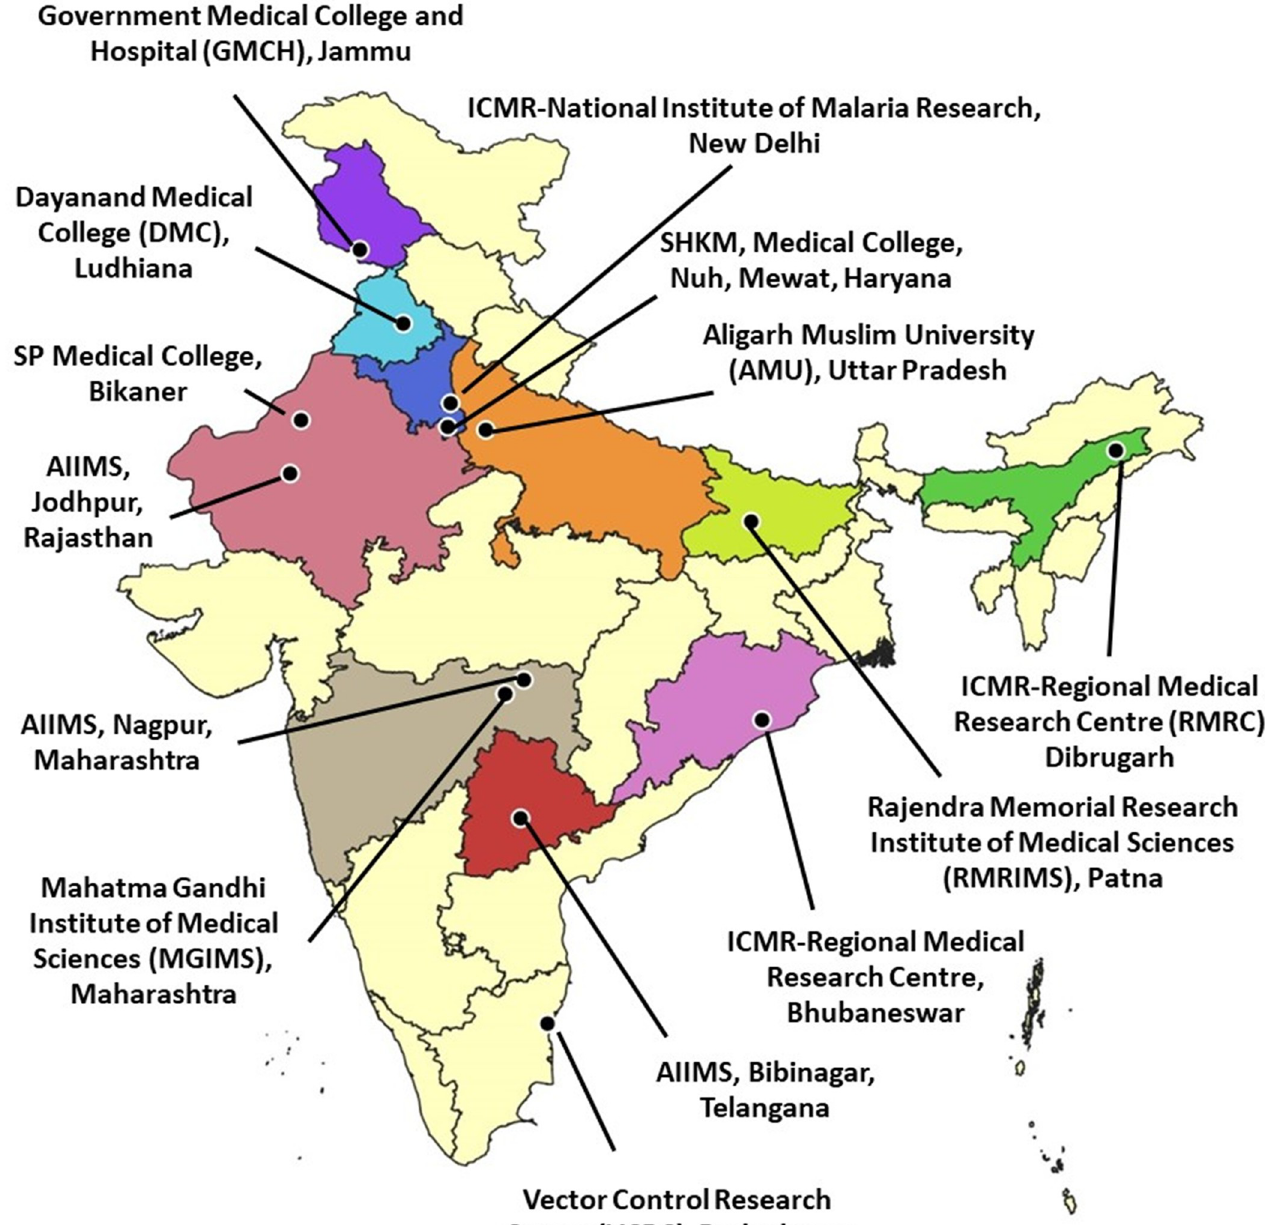
Fig 1. Map showing the participating institutes in the cross-sectional, online population-based survey for healthcare workers.